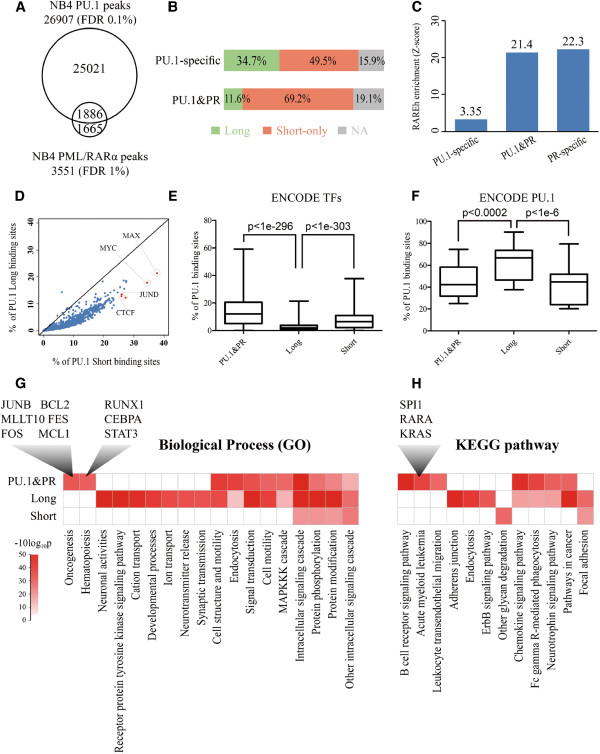
PU.1 binding sites with short motif selectively targeted by other factors including PML/RARα. (A) Venn diagram displaying the overlap of PU.1 binding regions and PML/RARα binding regions in NB4 cells. (B) Schematic illustration of the PU.1 motif comparison between PU.1 binding regions and PML/RARα binding regions. PU.1-specific is the subpopulation of PU.1 binding regions that do not overlap with PML/RARα binding regions. PU.1&PR is the subpopulation of PU.1 binding regions that overlap with PML/RARα binding regions. The color bars indicate the percentages of the regions with the long, only short PU.1 motif and neither, with green, orange and gray, respectively. (C) Bar plot of Motif RARE half (RAREh) enrichment in three subpopulations. PU.1-specific and PU.1&PR mean the same as above. PR-specific is the subpopulation of PML/RARα binding regions that do not overlap with PU.1 binding regions. (D) Scatter plot showing the covered percentages of PU.1-specific binding sites with the long motif versus that with the short motif by ENCODE ChIP-seq data sets of transcription factors except PU.1. (E and F) Box plot of the covered percentages in three PU.1 binding sets, including PU.1&PR, Long and Short, by ENCODE ChIP-seq data sets of PU.1 and other factors, respectively. The “Long” represents the PU.1-specific binding set with the long motif, while the “Short” represents those only with the short motif. The differences between the two binding sets were assessed using the paired t-test. The p-values are shown in the panels. (G and H) Heat map of functional enrichment with the items of PANTHER gene ontology in biological process and KEGG pathways. The enrichment level (-10*log10 (p-value)) was indicated with red color. The “PU.1&PR”, “Long” and “Short” represent the corresponding gene sets to the sets of binding sites defined above.